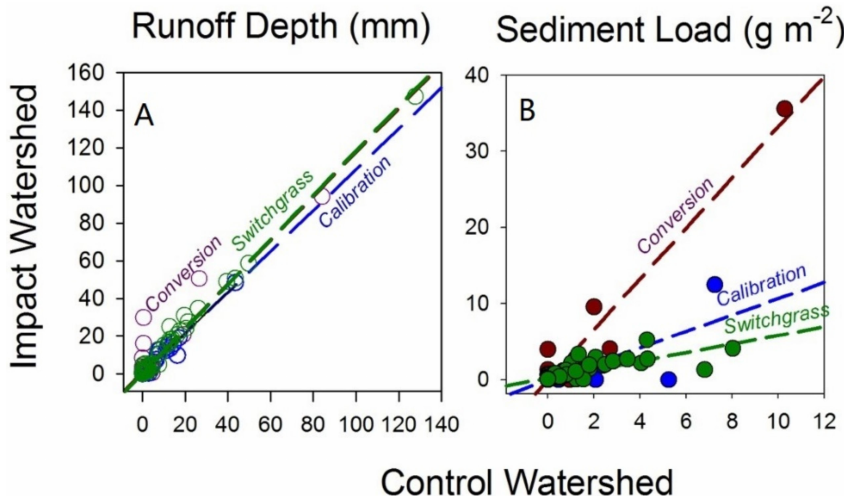
Figure 2. Relationships of event-based runoff and ( A ) sediment load ( B ) between the Control and Impact Watersheds during the calibration, conversion, and switchgrass